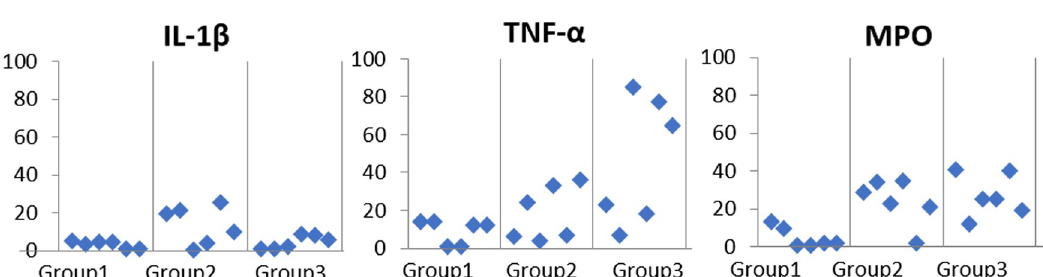
Fig 7. Gene expression results of direct USC injection into the bladder submucosa (Group 1), transurethral instillation of USC (Group 2) and USC injection via the tail vein (Group 3). IL-1 β , TNF- α and MPO gene expression was significantly lower in Group